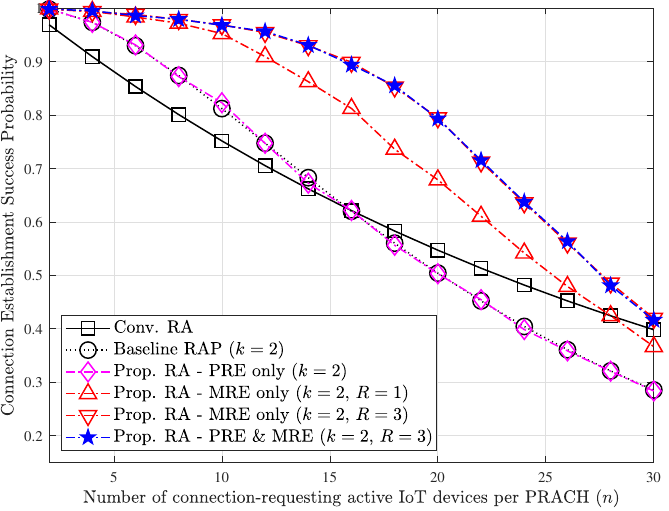
Figure 6. Effect of each of mechanisms on the connection establishment success probability.